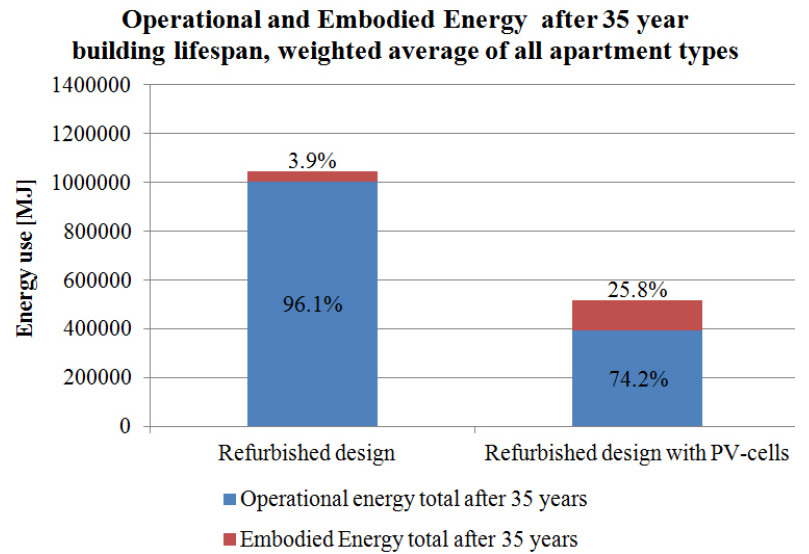
Figure 17. Embodied and operational energy accumulated over a lifespan of 35 years for the current building, refurbished building and refurbished building with the use of photovoltaic (PV)-cells. The current situation shows the energy use of the existing building without any refurbishment. The orange line gives the energy use of the refurbishment strategy as is described in Section 6.2. This design does not have PV-cells on the roof. In the red line the energy use of the exact same design is given with the use of PV-cells on the roof.